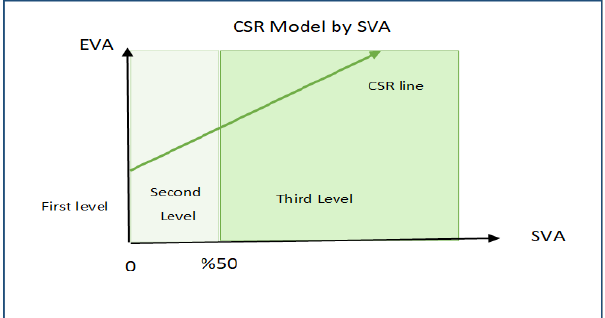
(Case Study: Nano-Engine Oil) Figure (3): The corporate social responsibility diagram by Social Value